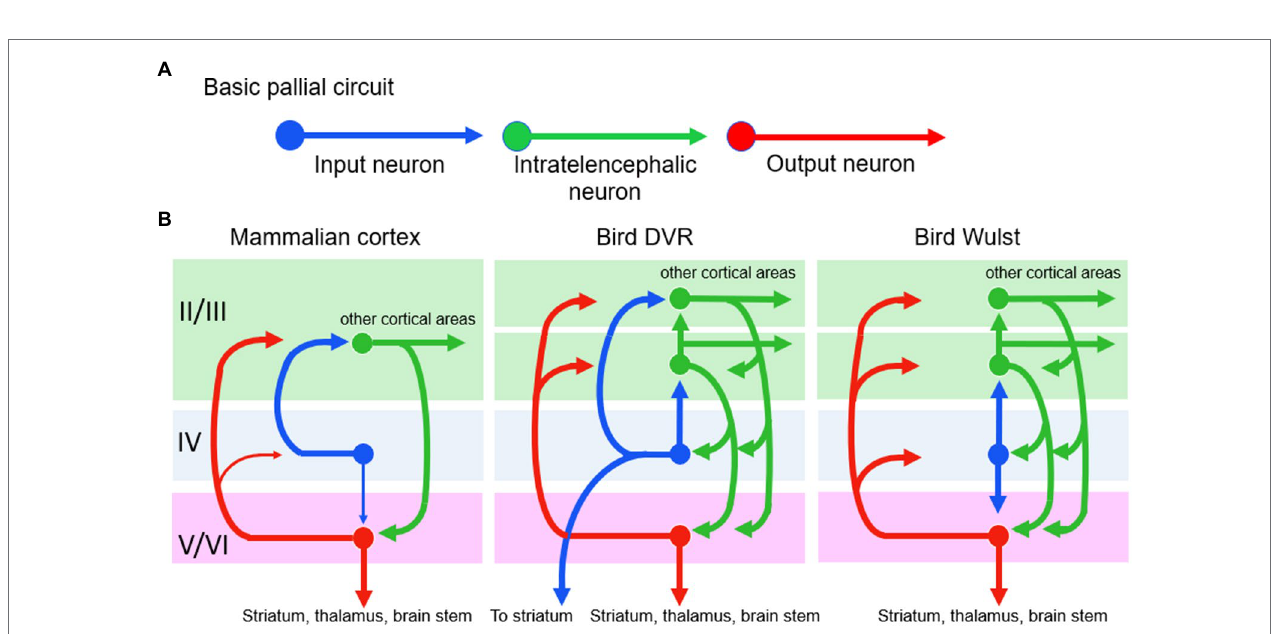
FIGURE 10 | The basic pallial circuit of three kinds of neurons (A) is present in mammals and birds. However, differences appear (among the similarities) when the circuit is shown in more detail (B) . At left, the numbers II to VI are the numbered layers and structures of Figure 9 . Modified from Stacho et al. (2020).